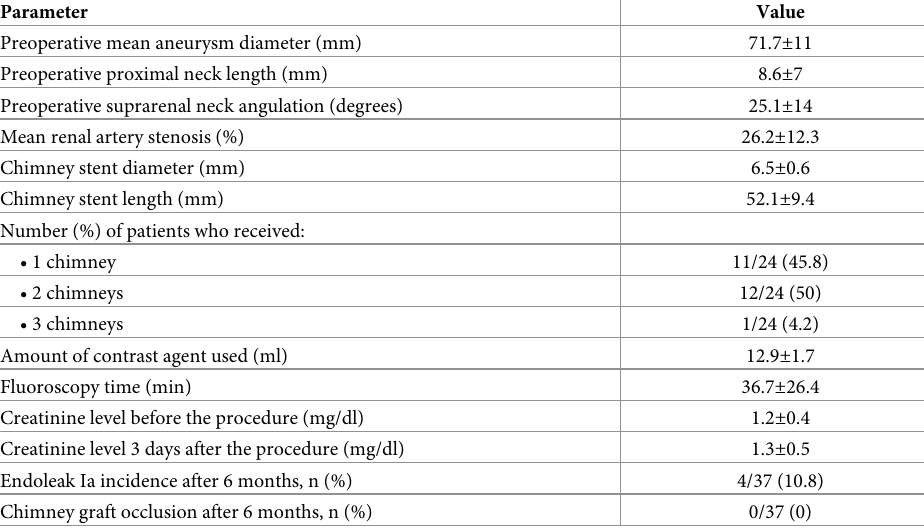
Table 2. Anatomical and clinical characteristics of the study